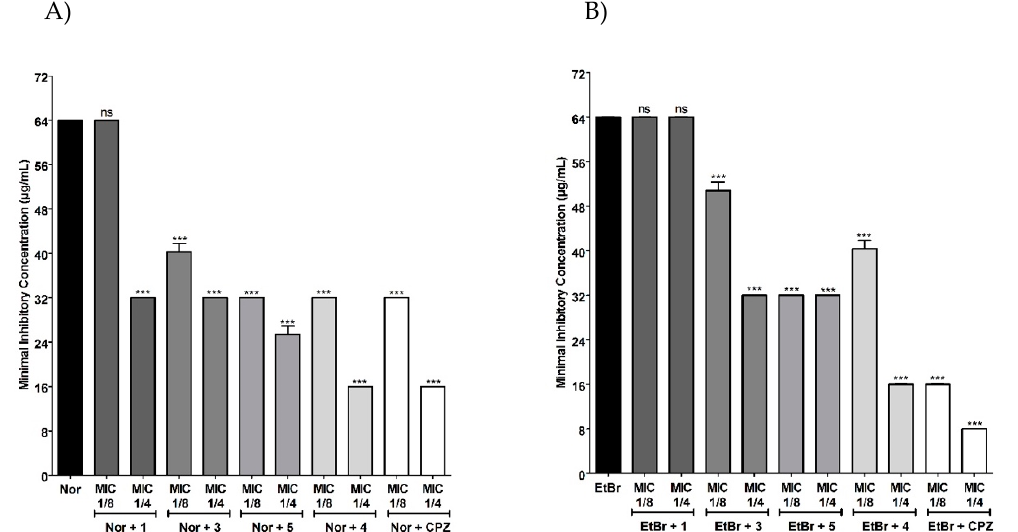
Figure 2. MIC values of ( A ) Norfloxacin ( Nor ) and ( B ) Ethidium Bromide (EtBr) in the absence or presence of chalcones 1 , 3 , 5 , 4 or Chlorpromazine (CPZ) against S. aureus SA1199-B (overexpressing norA gene). Each result represents the geometric mean of three simultaneous experiments. Di ff erences found between treatment with Norfloxacin or EtBr alone or associated with chalcones or CPZ were analyzed through one-way analysis of variance (ANOVA) followed by Bonferroni post-test and were considered statistically significant when p < 0.05. *** p < 0.0001.